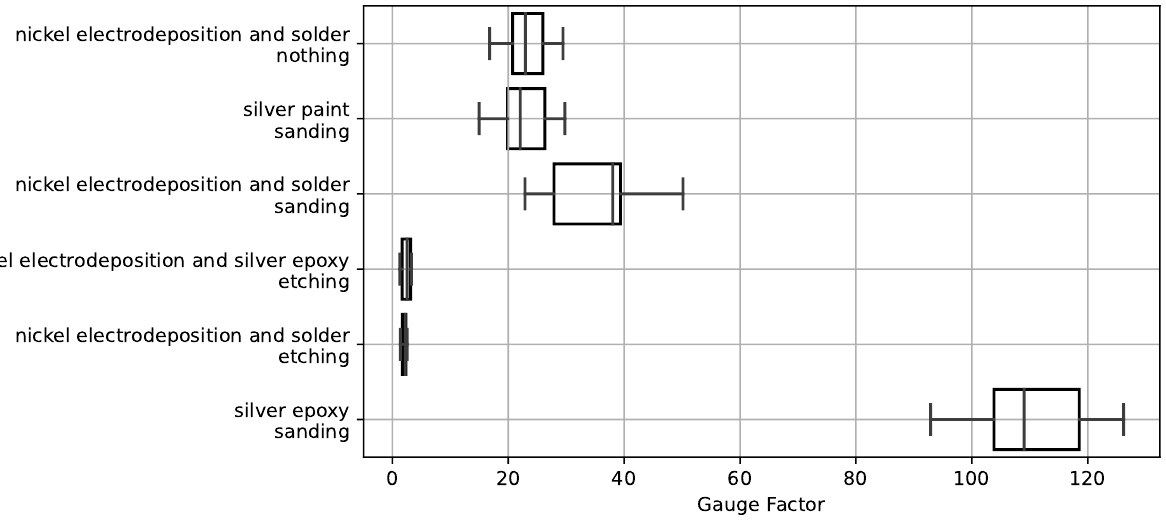
Figure 8. Apparent gauge factor for 2-wire measurements with different contacting methods and